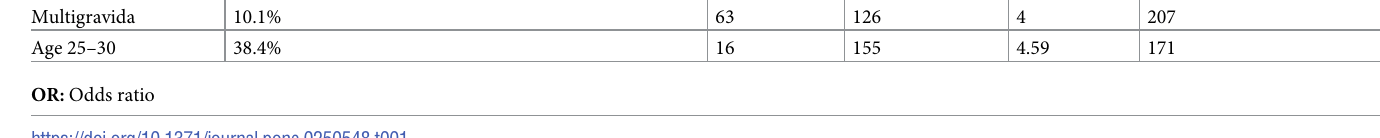
Table 1. Sample size calculation for second specific objective for PIH effect on maternal and foetal health among women gave birth in public health facilities. Variables Expected frequency of control among